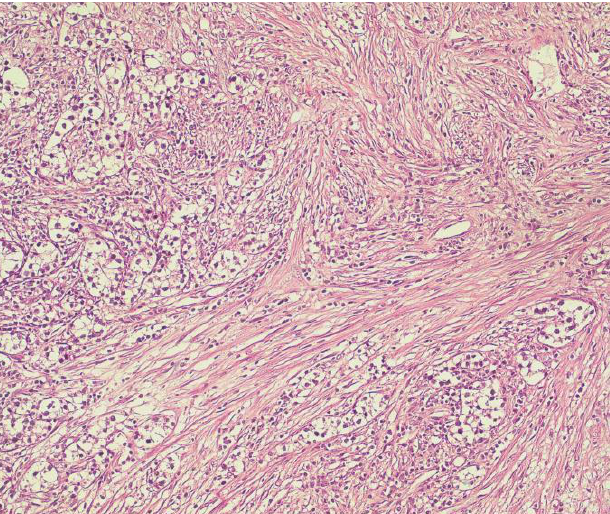
Figure 6. Parathyroid tissue with proliferation of clear cells, with solid – trabecular architecture and intensely desmoplastic stroma. (H and E, ×20).